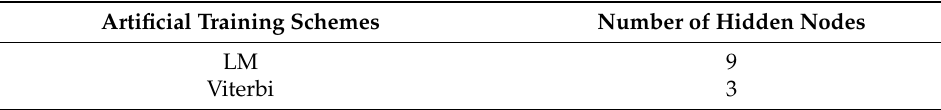
Table 4. Optimal structure analysis.